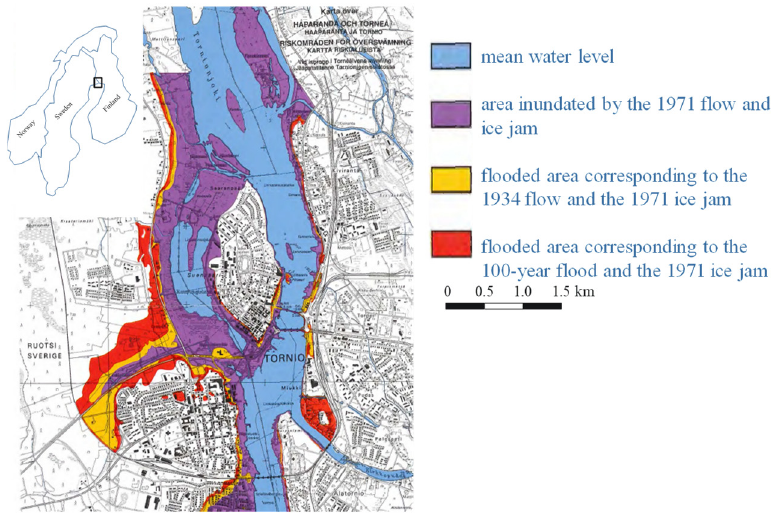
Figure 4. Extent of past ice-jam flood events [13].